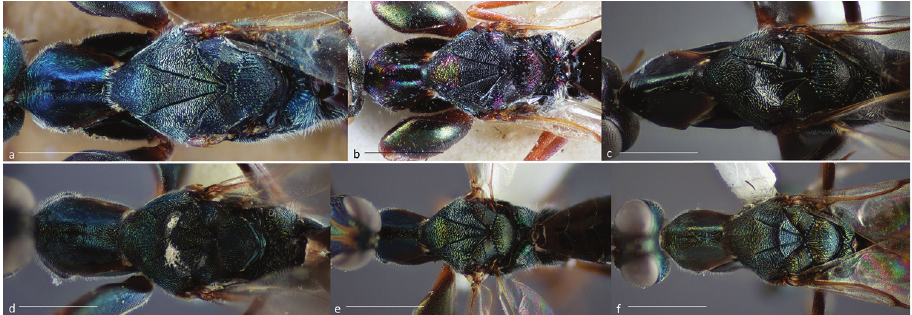
Figure 11. Mesosoma (dorsal) I a O. ahoma (Mani & Kaul) (imaged specimen: OAh01, holotype) b O. circularicollis sp. n. (OCi01, holotype), c O. felix sp. n. (OFe01, holotype) d O. fidelis sp. n. (OFi01, holotype) e O. florea sp. n. (OFl01, holotype) f O. formosa (Giraud) (OFo03). Scale bars: 1 mm.